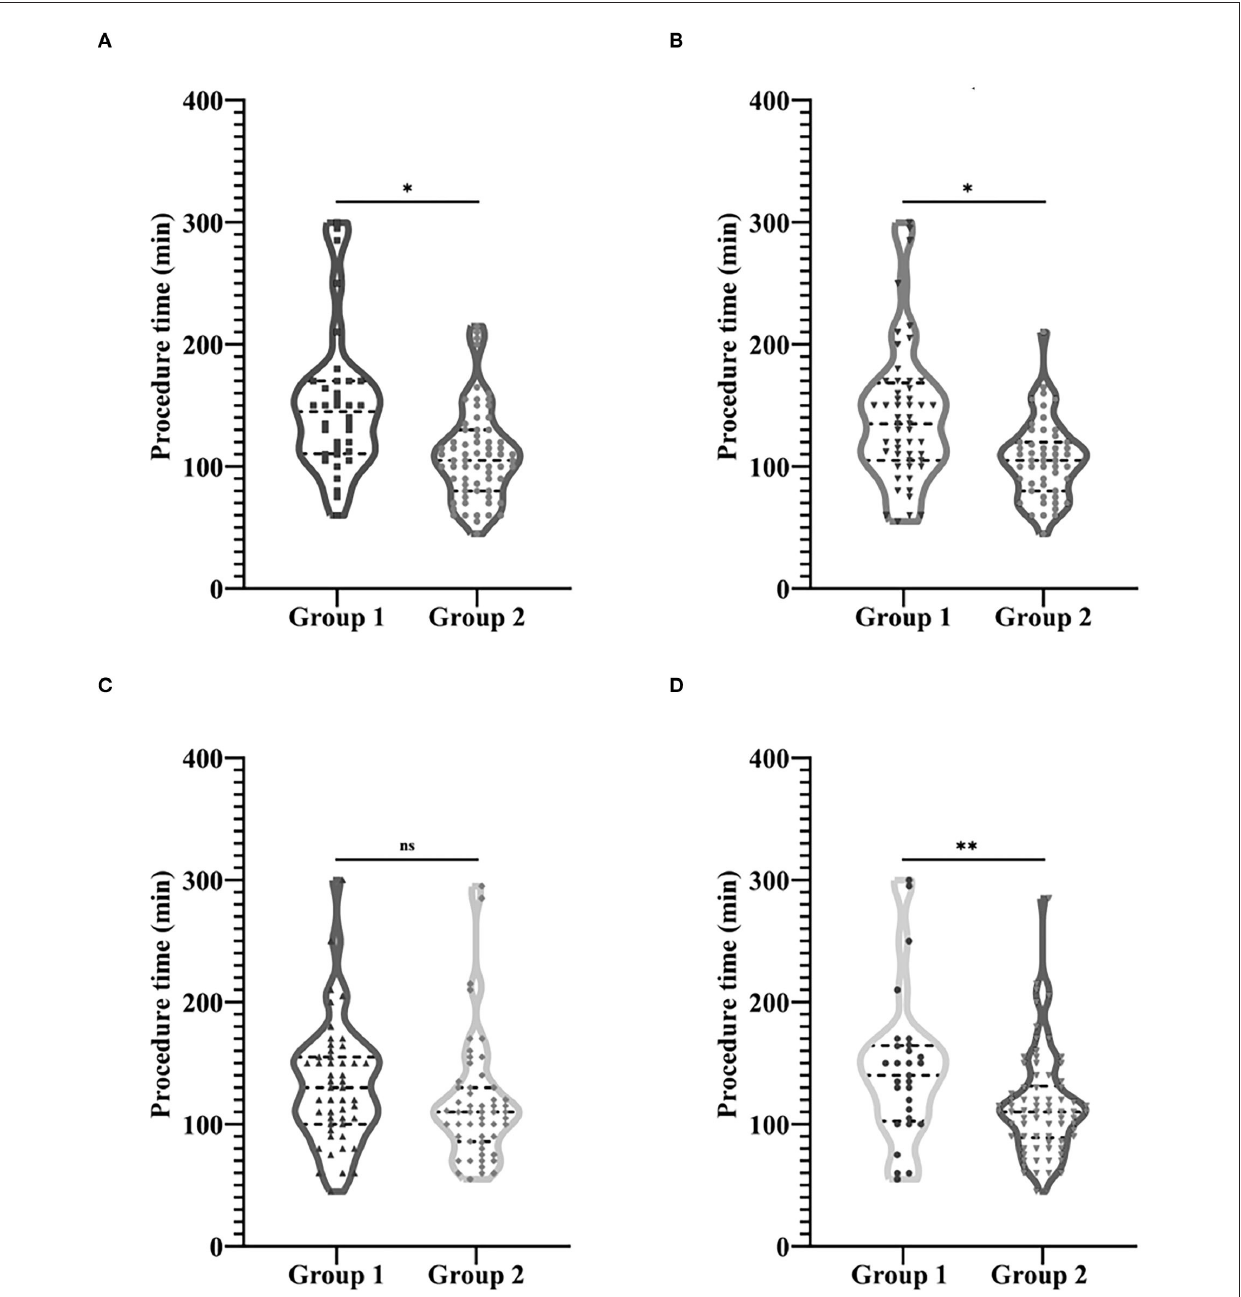
FIGURE 8 | Comparison of procedure time between groups based on the four most important factors. (A) Group 1, Group with blunt stump; Group 2, Group without blunt stump. (B) Group 1, Group with side branches; Group 2, Group without side branches. (C) Group 1, Group with occlusion lesions exceeding 2cm; Group 2, Group with occlusion lesions no more than 2cm. (D) Group 1, Group with calcification or organization; Group 2, Group without calcification or organization. * P < 0.001, ** P = 0.006.